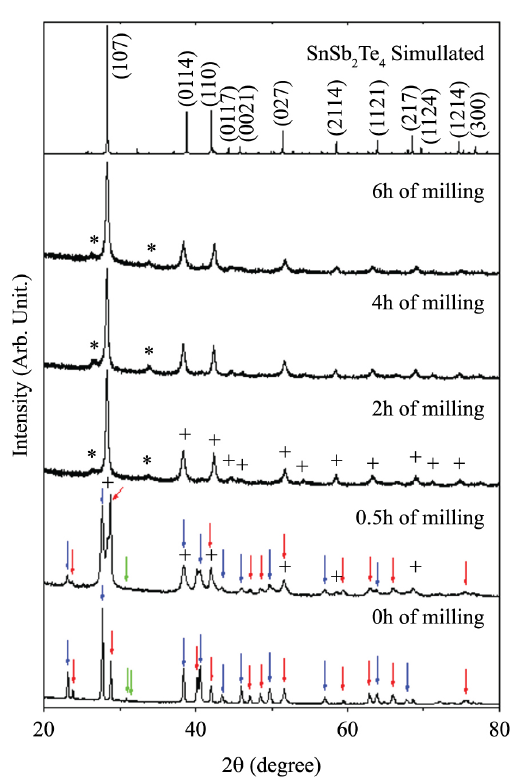
Figure 1. (color online) Structural evolution of the SnSb after milling times for 0, 0.5, 2, 4 and 6h. This figure also displays (on top) the simulated diffractogram for SnSb PCW software 12 . All peaks indicated by crosses can be indexed as SnSb Te reflections and minor peaks corresponding to SnO 2 4 indicated by asterisk symbol. Sn, Sb an Te are indicated by green, red and blue narrows respectively.